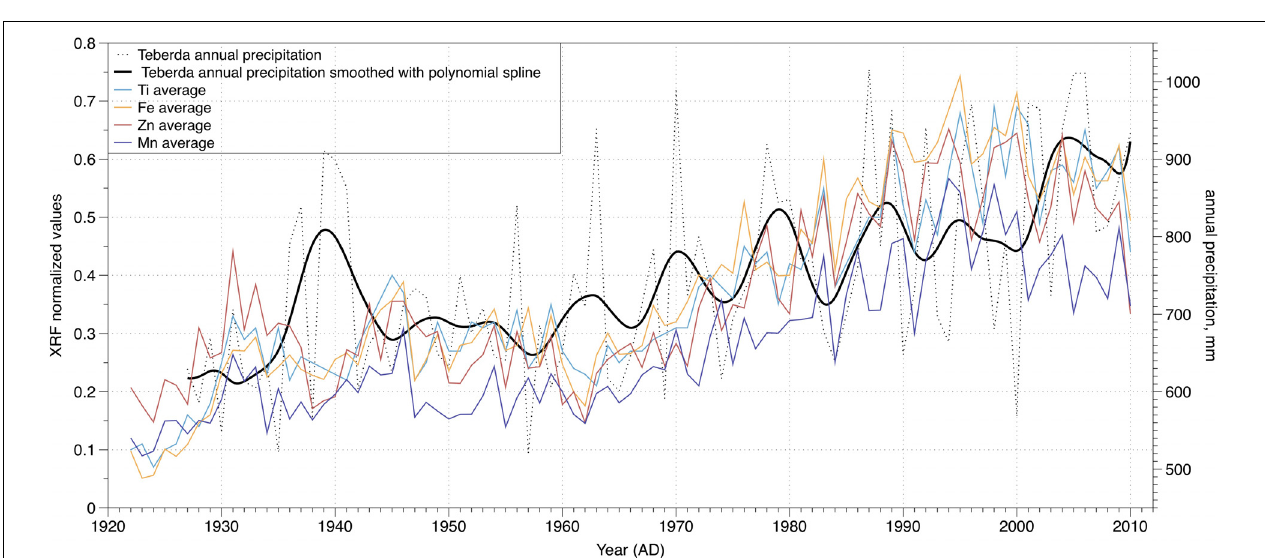
ablation and JJA mean and mean maximum air temperatures, respectively) (Shahgedanova et al., 2005). Sedimentary elemental data compared with Djankuat ablation directly yield lesser (up